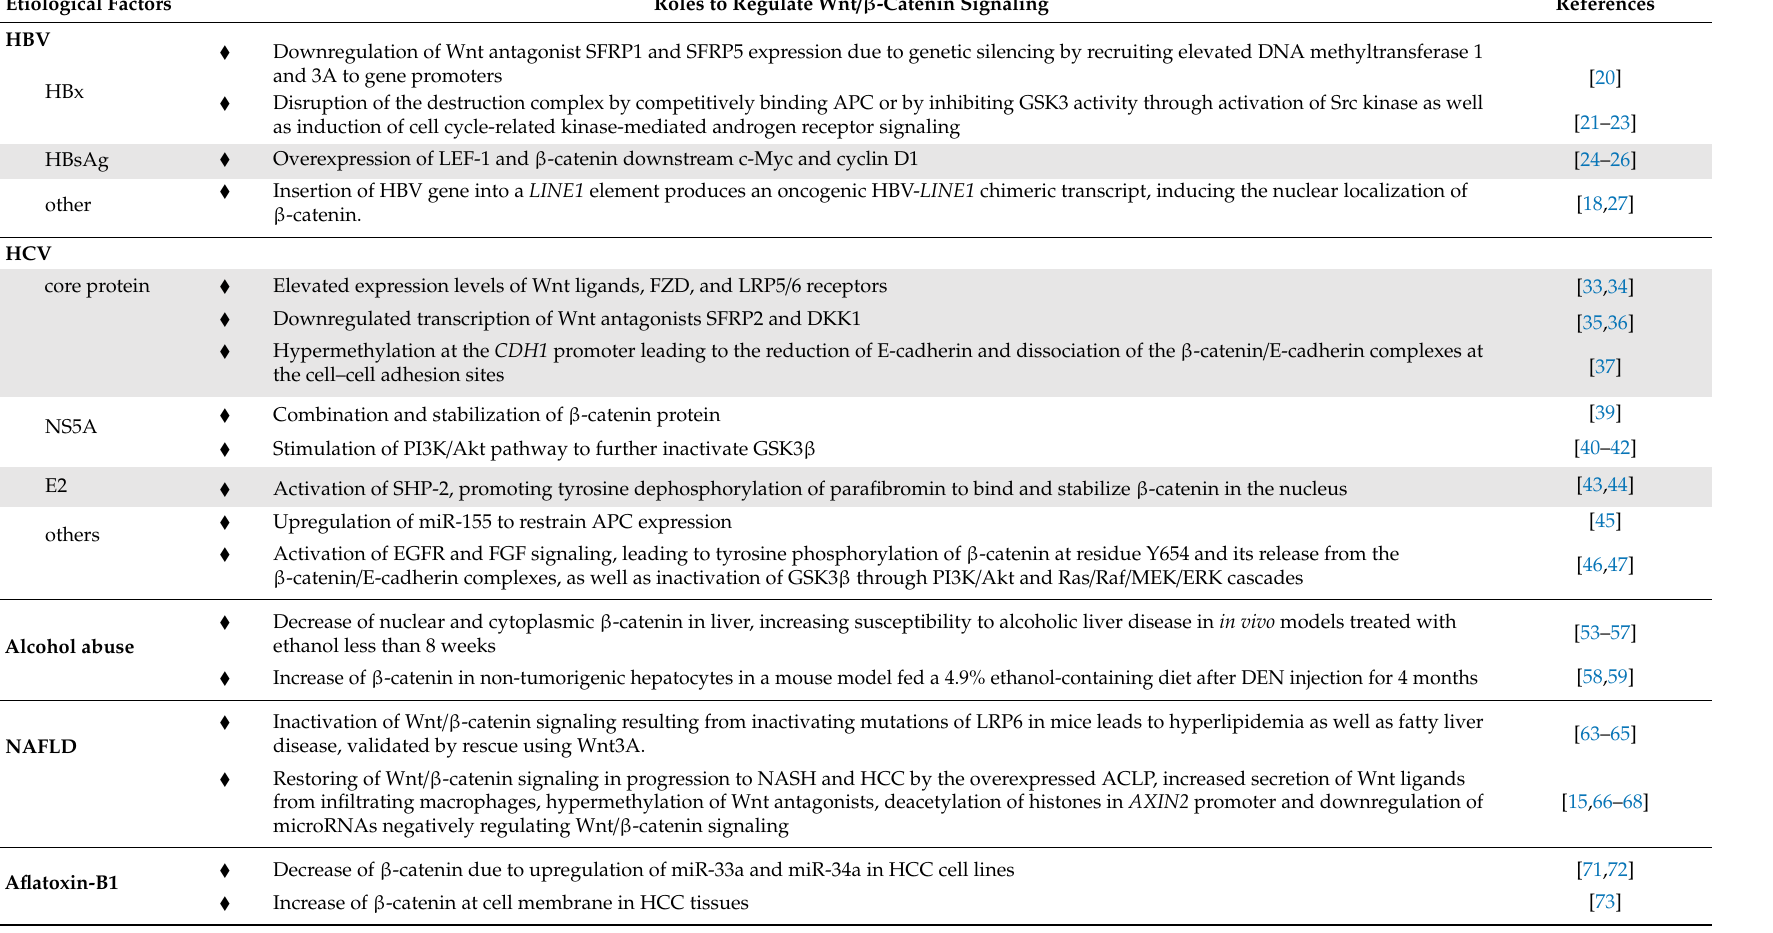
Table 1. Summary of the function of etiological factors on the regulation of Wnt / β -catenin signaling. Etiological Factors Roles to Regulate Wnt / β -Catenin